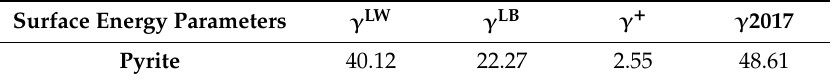
Table 3. Surface energy parameters of pyrite (mJ / m 2 ).